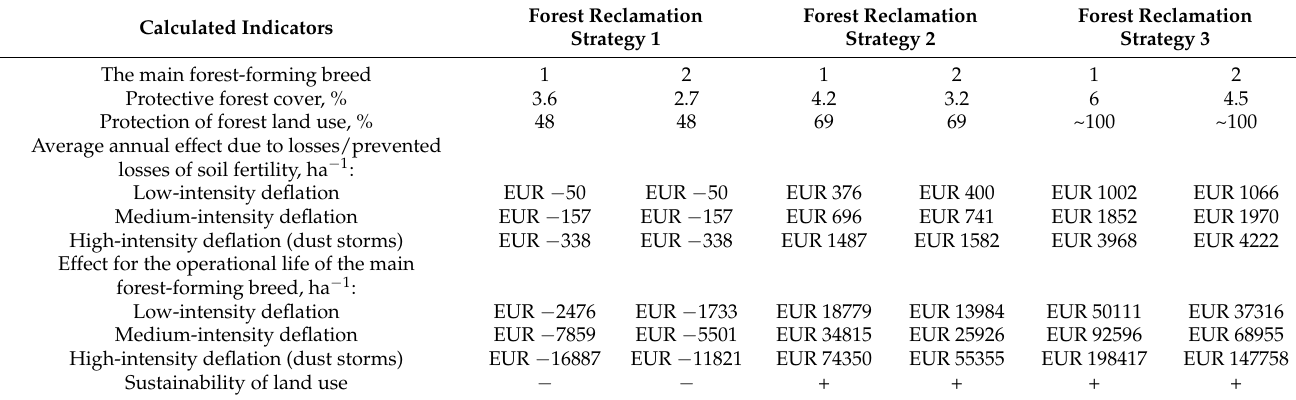
Forest Reclamation Forest Reclamation Forest Reclamation Strategy 1 Strategy 2 Strategy 3